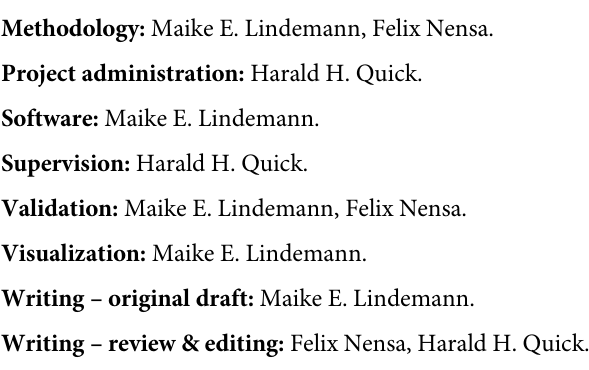
to truncation correction with HUGE. The HUGE method results in realistic body contouring with a slight underestimation of true arm volume. S2 Fig. HUGE raw data of a patient example with failed HUGE AC-map. The figure depicts the Dixon-VIBE and HUGE AC-maps, the HUGE raw data of left and right side and fusion images of the HUGE AC-map with HUGE raw data for both sides in axial and coronal orienta- tion for patient #24 where the HUGE AC-map failed. Note that parts of the right arm are miss- ing in the HUGE AC-map due to failed segmentation in some regions (red arrows). HUGE raw data show the truncation correction in those regions (red arrows). In this single case the HUGE AC-map segmentation failed despite correct acquisition of HUGE raw data. S1 Table. Detailed patient information. The table lists all relevant patient data, e.g. body mass index (BMI) and the post injection time (p.i.). Note that patient numbering in Fig 3 does not correspond with this list as patients in Fig 3 are sorted by increasing BMI. S2 Table. Total segmented volume of AC-maps. The table lists the segmented total volume of AC-maps (reference) and calculated relative differences of the HUGE and MLAA-based AC-maps compared to Dixon AC-maps. Note that patient numbering in Fig 3 does not corre- spond with this list as patients in Fig 3 are sorted by increasing BMI. S3 Table. Activity in polar plot segments. The table lists the activity in each polar plot seg- ment and calculated relative differences of the HUGE and MLAA corrected PET images com- pared to Dixon-VIBE corrected PET images. Note that patient numbering in Fig 3 does not correspond with this list as patients in Fig 3 are sorted by increasing